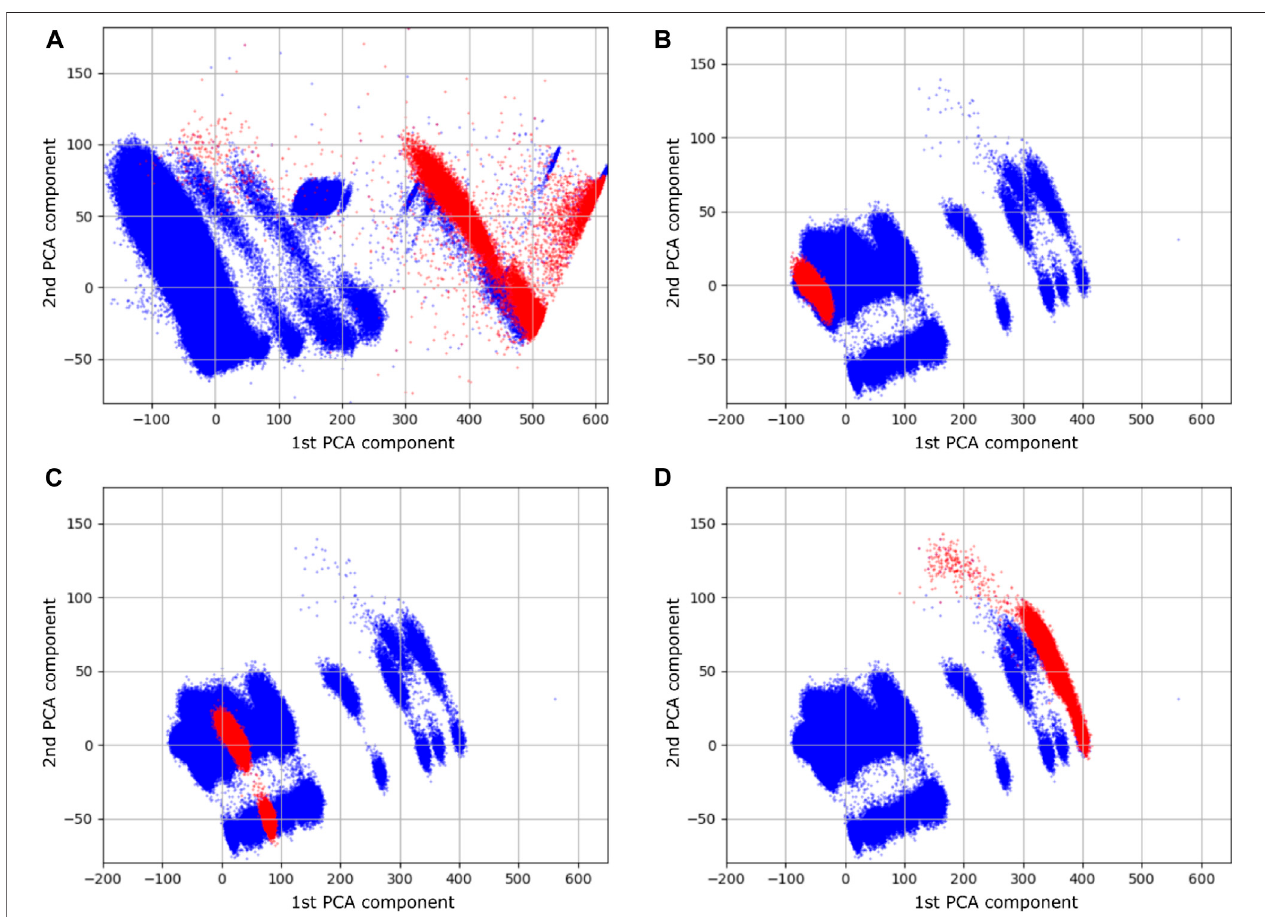
FIGURE12| Operationundernormalconditions,on/off-signalsfromtheacousticintensityprobe (A) ,rotordeceleration-signalsfromacousticintensityprobe (B) , continuous operation -signals from the accelerometer (C) , on/off signals from the accelerometer (D) .